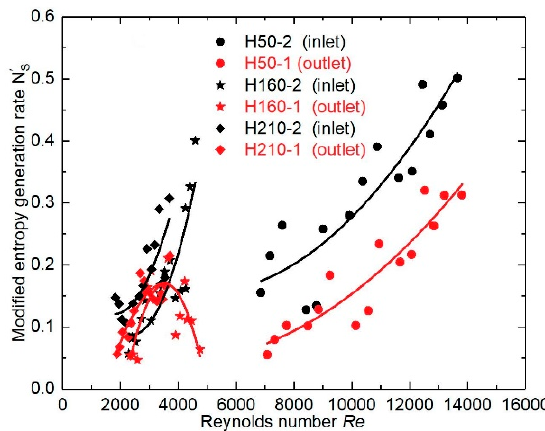
(cid:3046)(cid:4593) ) versus Reynolds number ( 𝑅 (cid:3032) ).